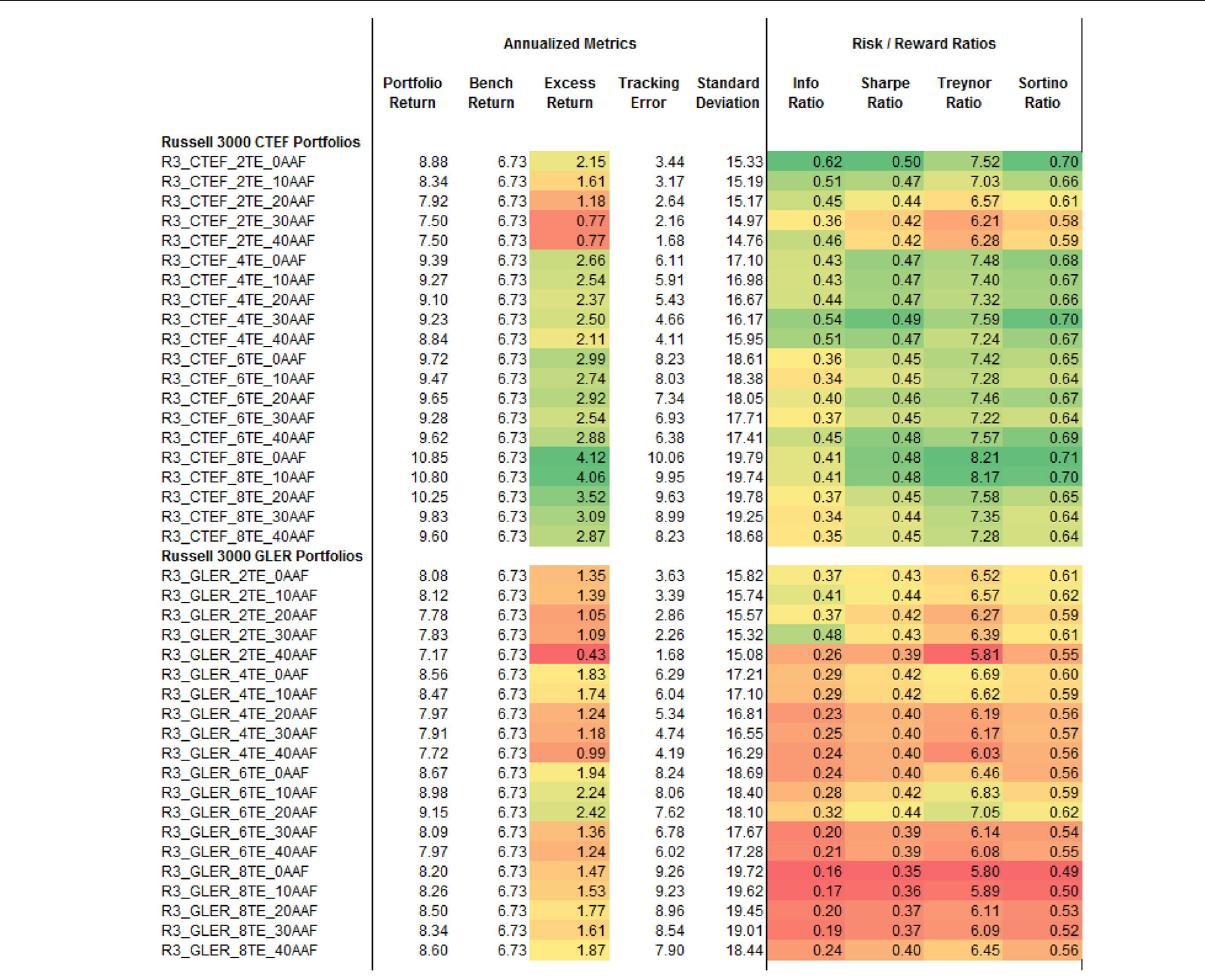
FIGURE 1 | U.S. Portfolios. Heat map colors in Figures 1 – 4 represent degree to which a given value is positive or negative relative to its own column. Green is positive, red is negative, and yellow is in